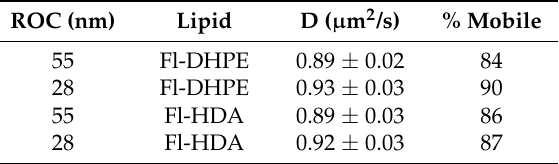
Table 1. Diffusion coefficients and fraction mobile measured from FRAP recovery